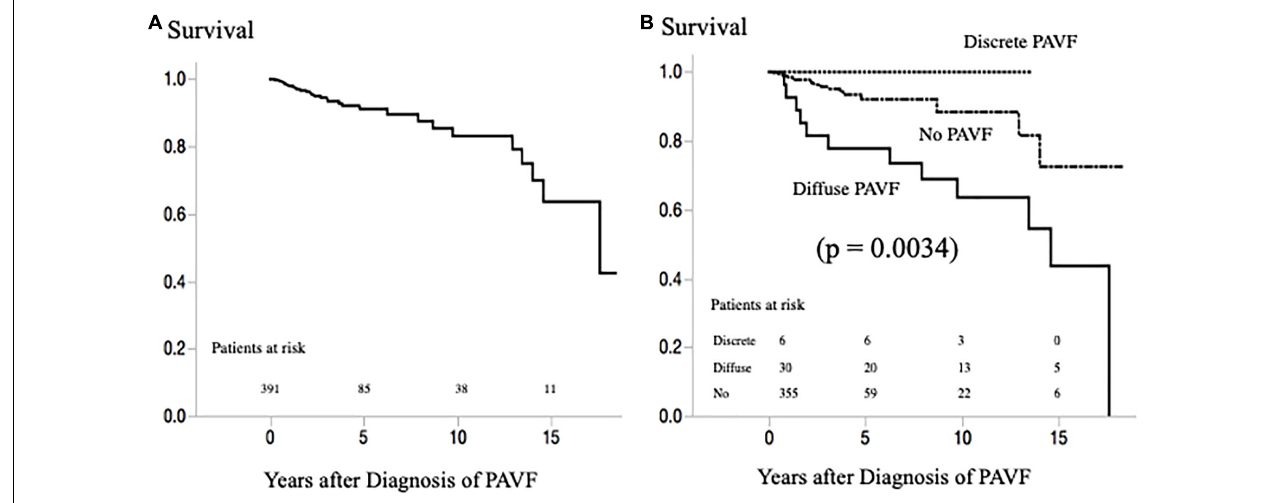
FIGURE 5 | (A) Survival rate after latest evaluation of PAVF in all patients with a Fontan circulation. (B) Survival rate after latest evaluation of PAVF according to the morphology of PAVF. PAVF, pulmonary arteriovenous fistulae.